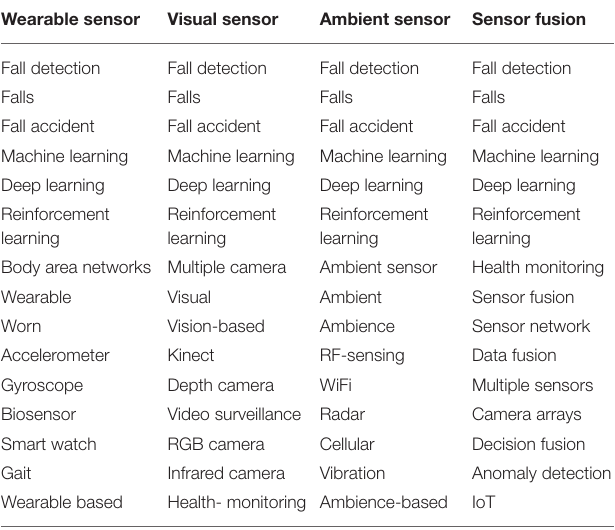
TABLE 1 | The most frequently used keywords in the topic of fall detection.